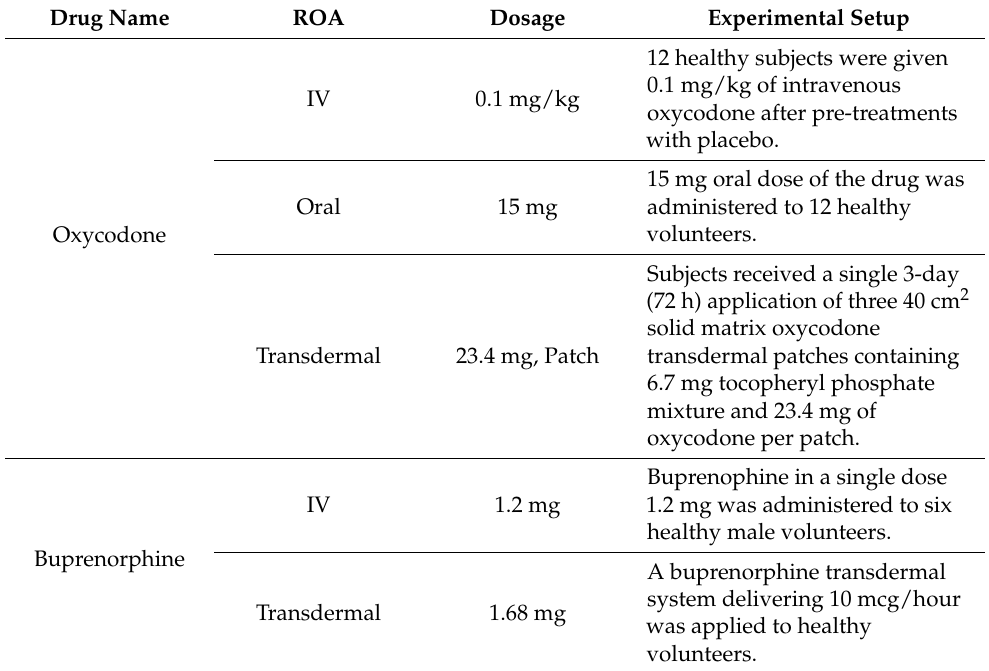
Table 2. Background on datasets used for systemic plasma-venous compartment disposition simula- tion and optimization of missing PK